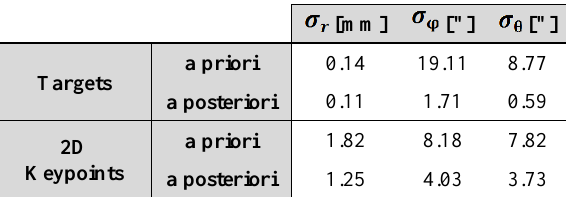
Table 2. The standard deviations in ranges, horizontal and vertical angles of the target centroids and 2D keypoints, before